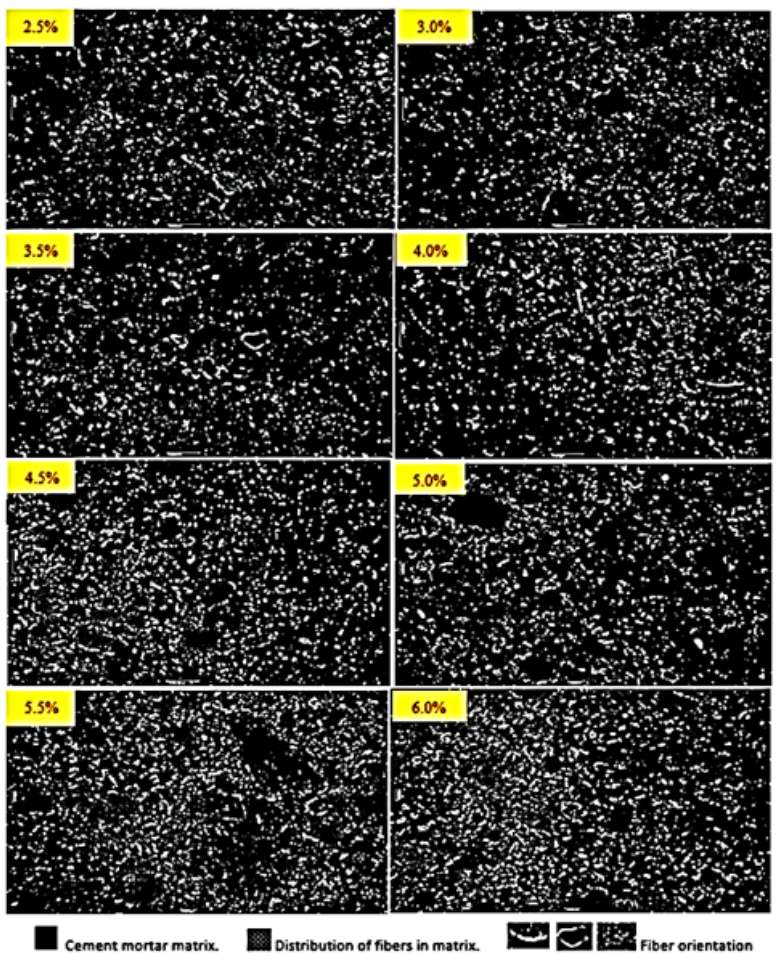
Figure 12. Beam cross-section images of CSWF distributions with ratios of 2.5% to 6%, cut verti- cally.